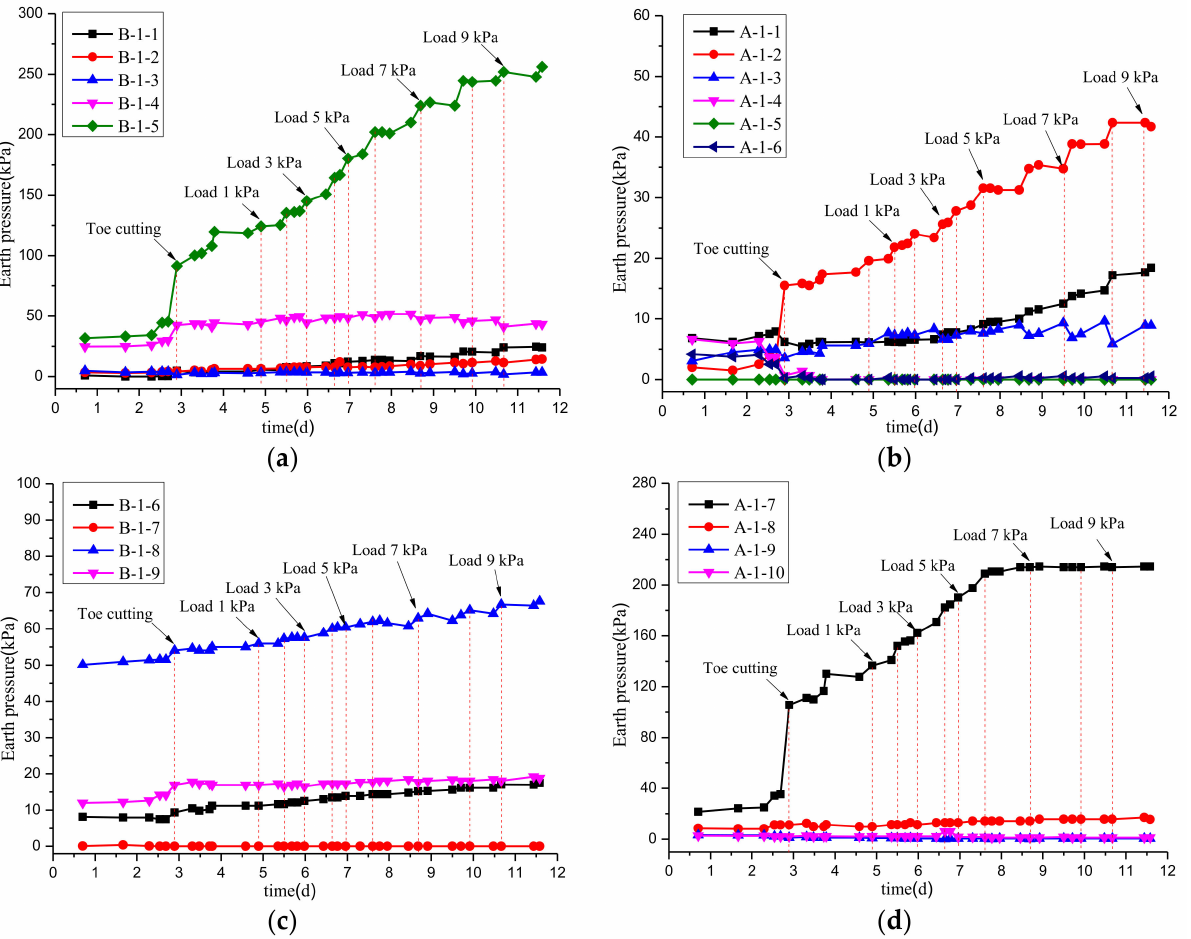
Figure 12. Earth pressure of pile no. 1: ( a ) curves of earth pressure before the anti-sliding segment of pile no. 1; ( b ) curves of earth pressure behind the anti-sliding segment of pile no. 1; ( c ) curves of earth pressure before the anchoring segment of pile no. 1; ( d ) curves of earth pressure behind the anchoring segment of pile no.